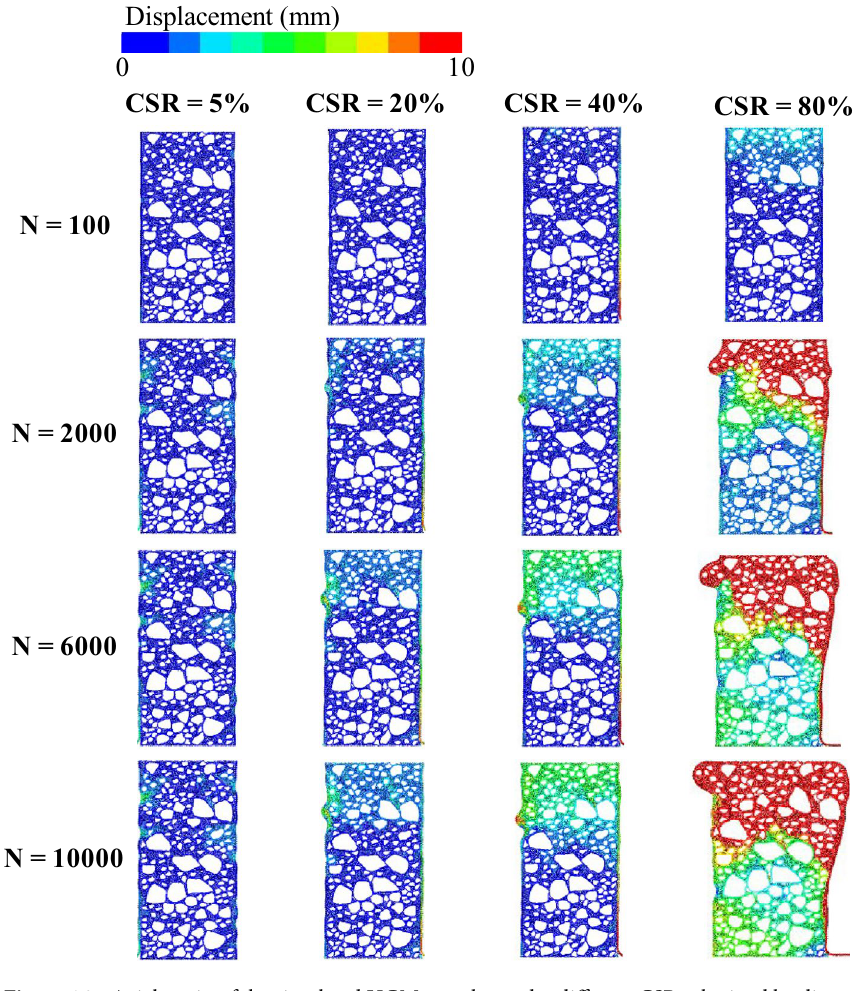
Figure 14. Axial strain of the simulated UGM samples under different CSRs obtained by discrete element